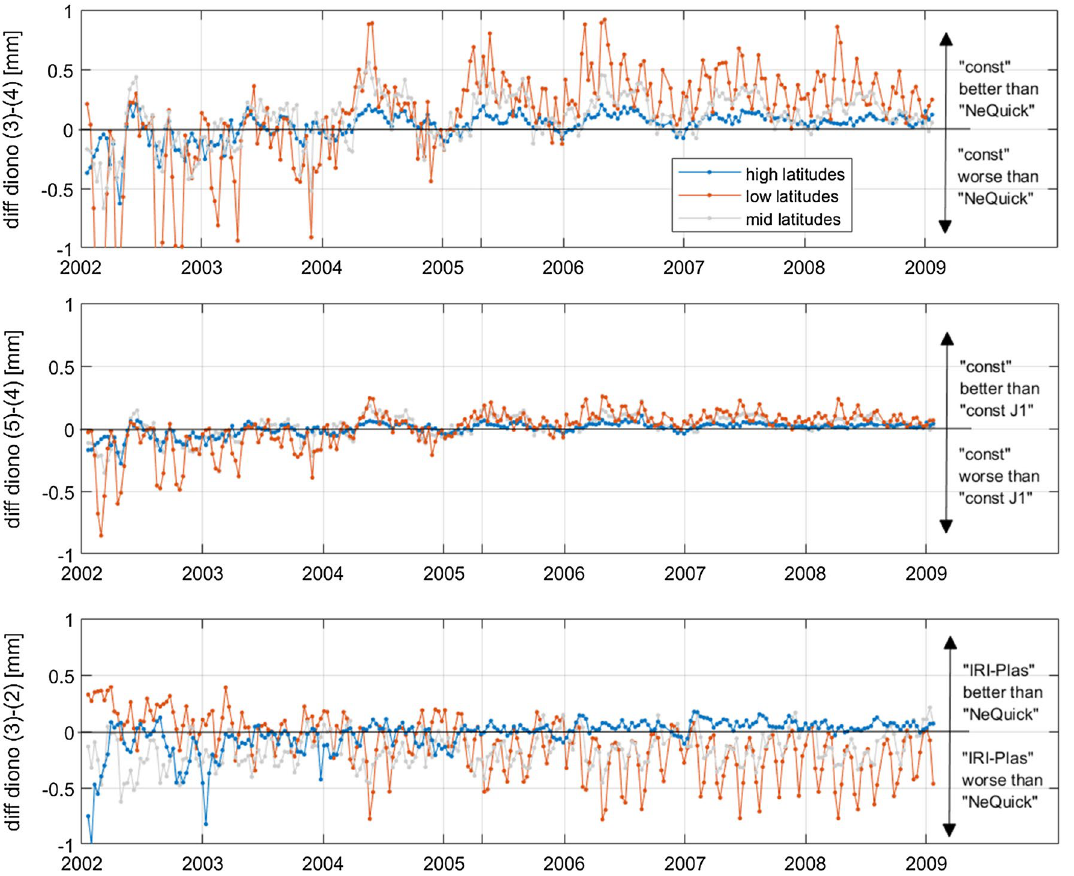
Fig. 5 Difference of standard deviations per Jason-1 cycle between constant scaling and scaling by NeQuick ratio (top plot), constant scaling by different factors (middle), and between IRI-Plas and NeQuick scaling. The standard deviations are computed for different classes of geomagnetic latitude (low: red, high: blue, mid: grey). The grey line in April 2005 indicates the change from high solar activity to low solar activity (R12